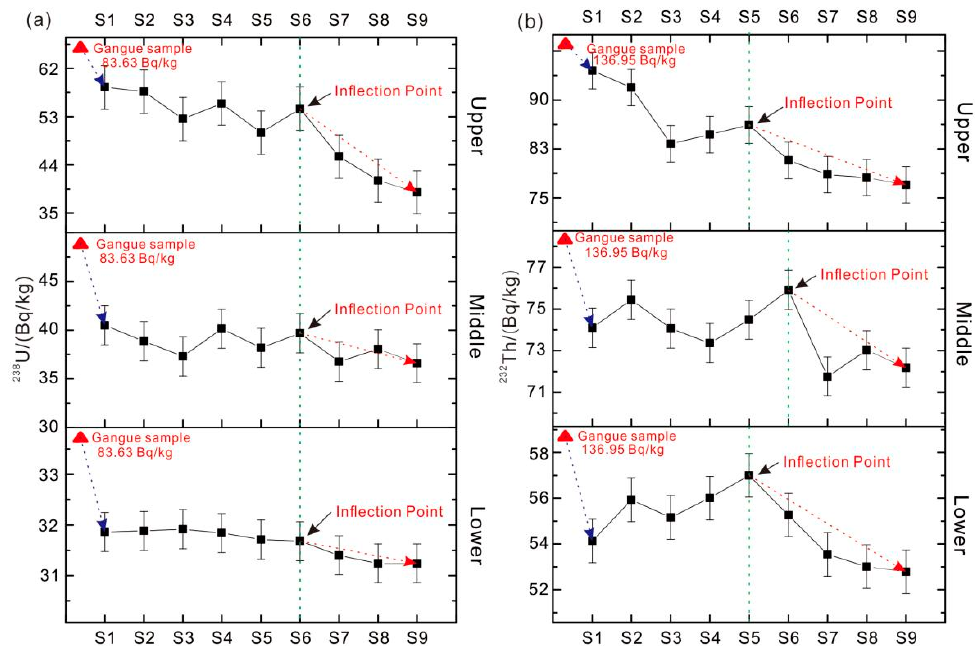
Figure 4. Specific activity of coal gangue and surrounding soil samples: ( a ) 238 U; ( b ) 232